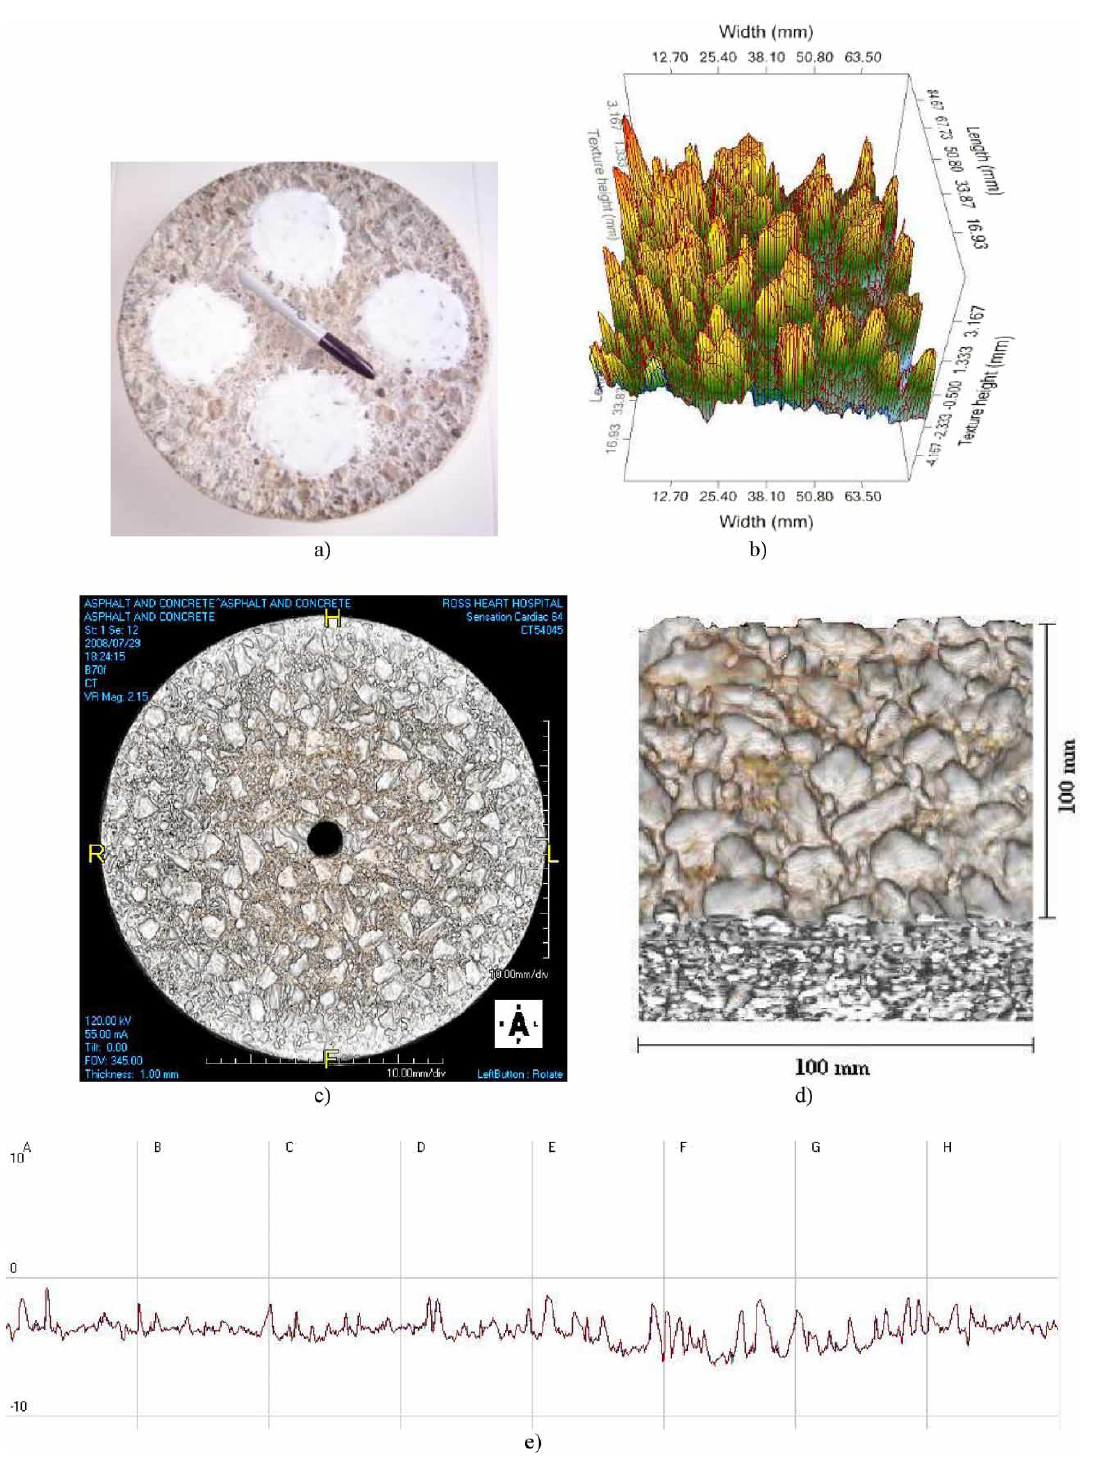
Fig. 3. Procedures and results for an exposed aggregate concrete sample from: (a) sand patch test; (b) laser texture scanner; (c) and (d) x-ray CT scanning; (e) CT meter surface profiling (in